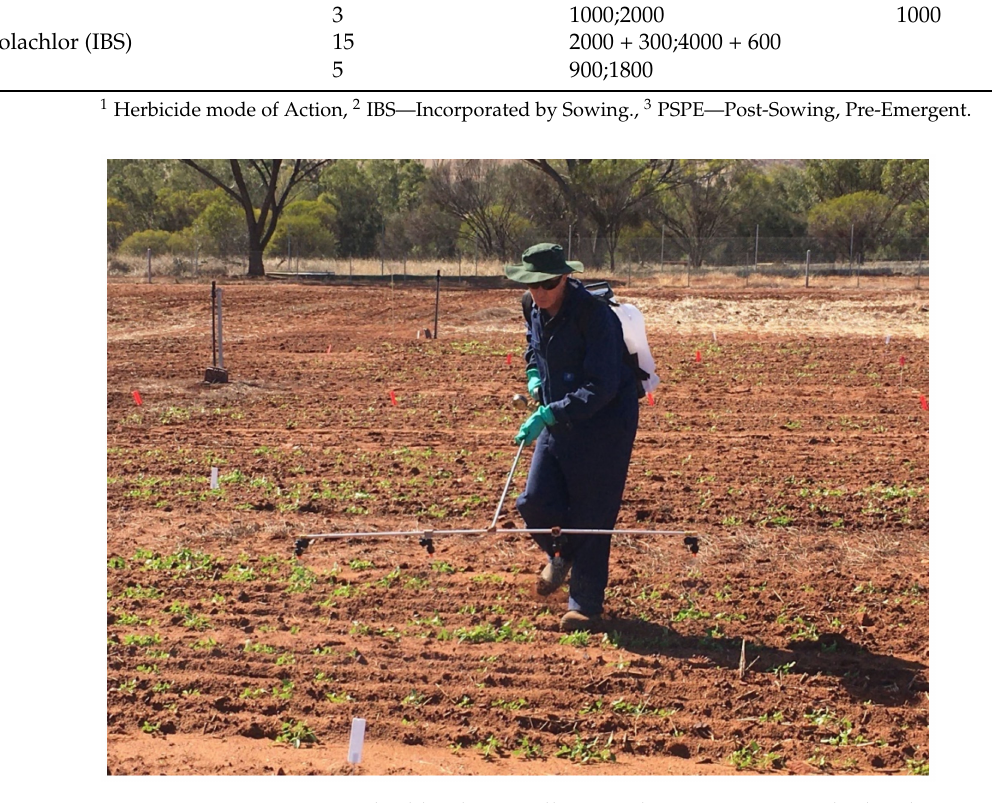
Figure 2. Spraying 1-month-old tedera seedlings with 7 post-emergent herbicides experiment